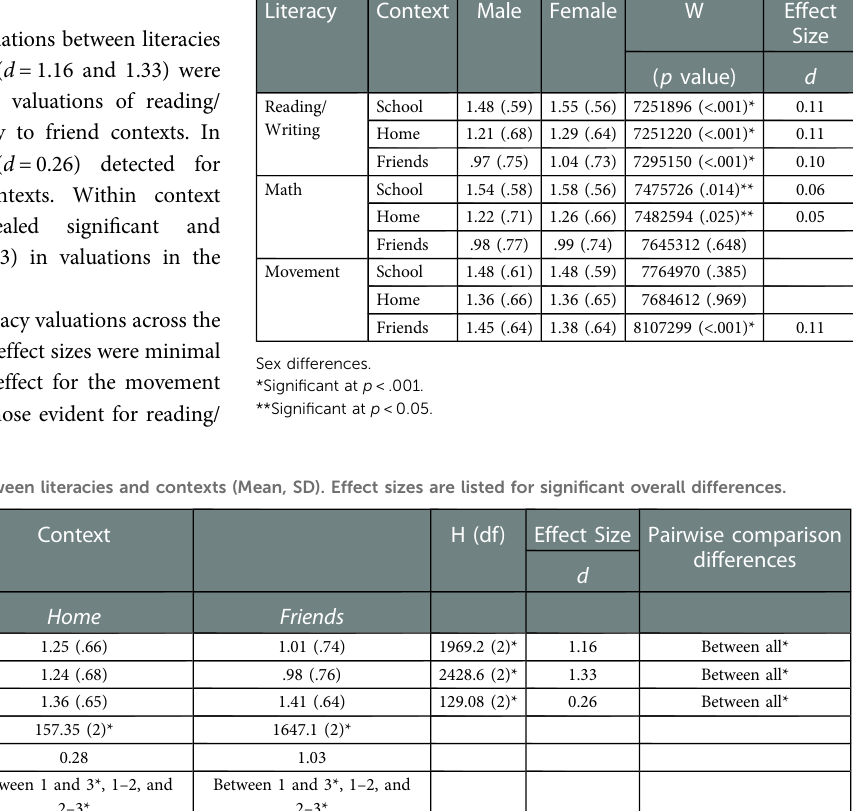
TABLE 2 The literacy valuations (Mean, SD) at school, home and with friends separated by sex. Effect size is reported for signi fi cant differences.